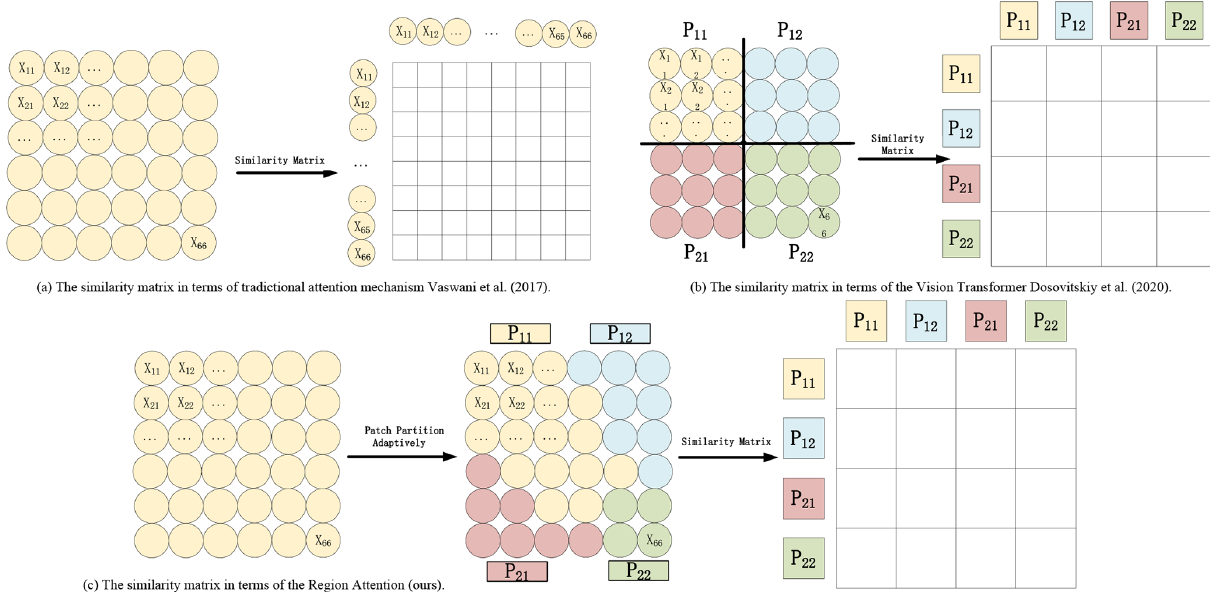
Figure 3. The calculation process of a similarity matrix, based on three different attention